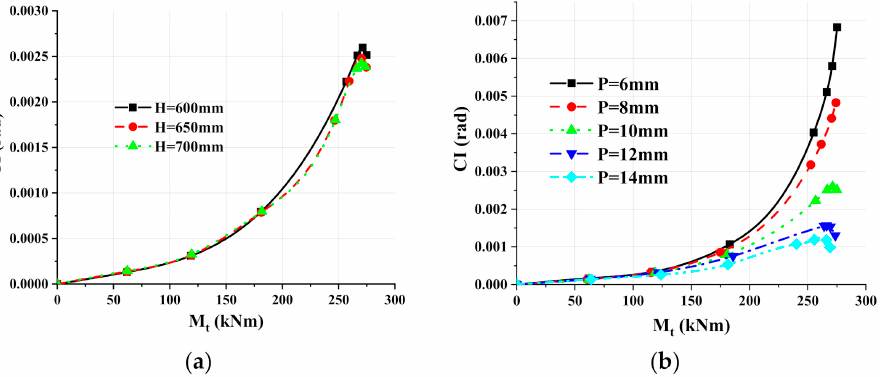
Figure 19. Continuity index-moment curves of connections: ( a ) The height of inbuild component; ( b ) The thickness of inbuild